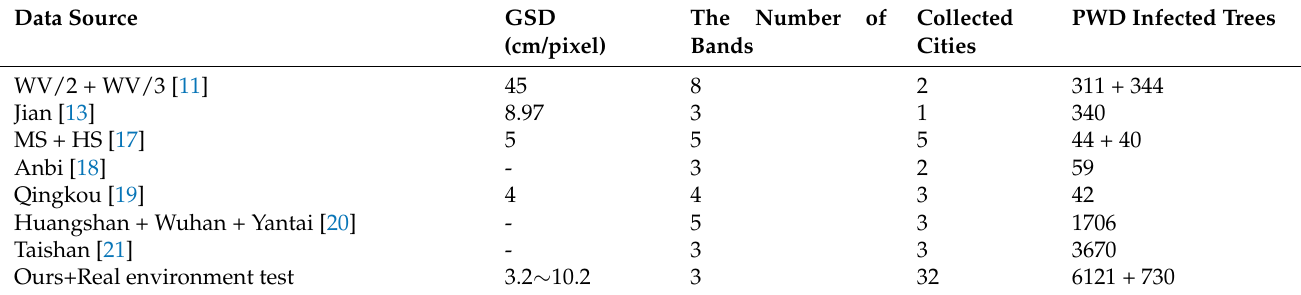
Table 1. Information about the data sets in various approaches. Symbol “-” denote the missing data in reference